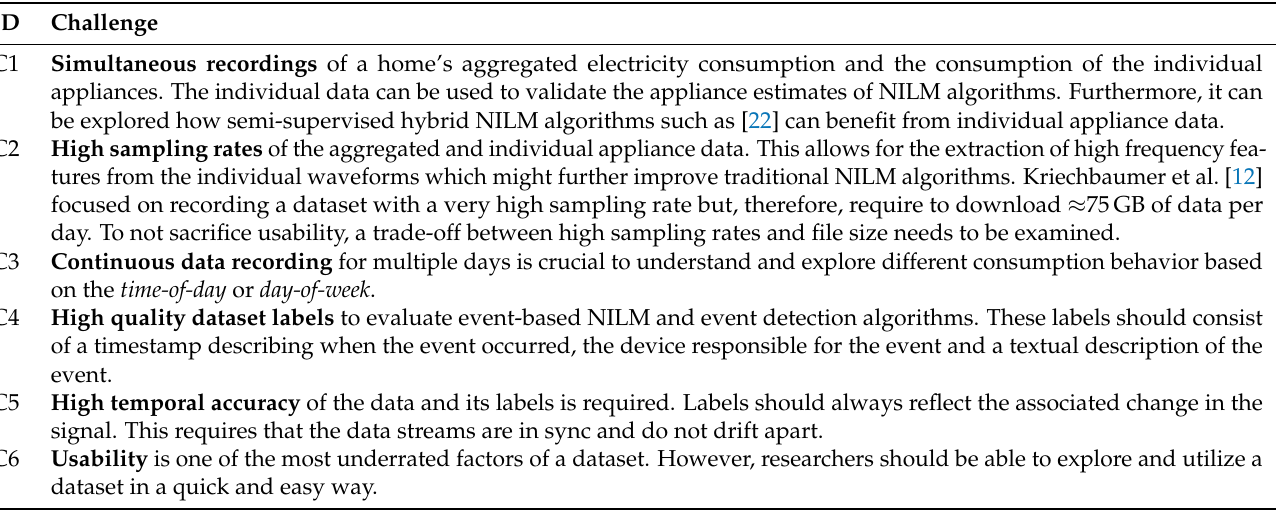
Table 1. Challenges that need to be addressed when recording datasets for Non-Intrusive Load Monitoring.